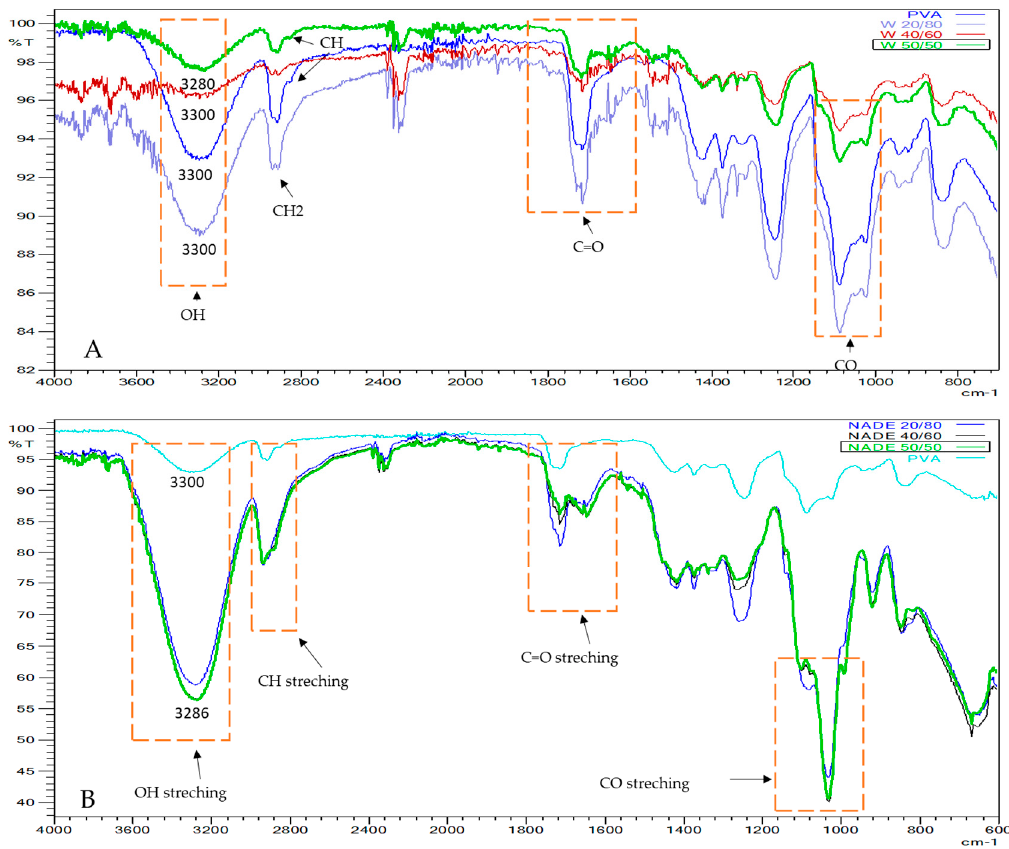
Figure 6. Spectrum for each nanofiber produced: ( A ) PVA, W 20/80, W40/60, and W50/50; ( B ) PVA, NADES 20/80, NADES 40/60, and NADES